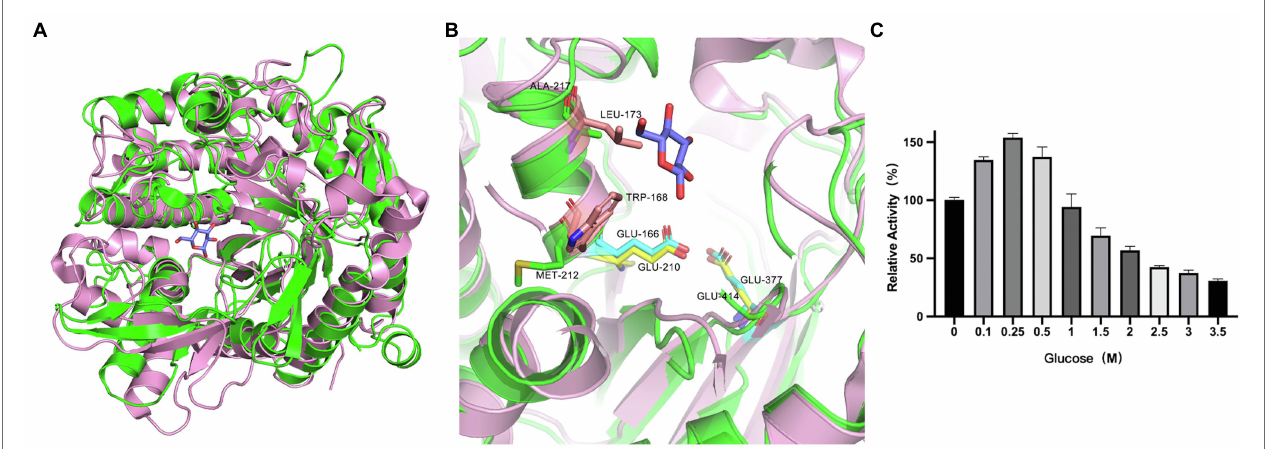
FIGURE 7 | Analysis of active-site accessibility. (A) Structural comparison of TsBGL (green) with HiBG (pink, PDB: 4MDP, RMSD = 1.316). (B) The stick representation of the two gatekeeper residues (Trp168 and Leu173) in HiBG substituted with a Met212 and Ala217 in TsBGL. (C) Effects of glucose concentration on the activities of M212W|A217L mutant. The value obtained without glucose in the reaction mixture was taken as